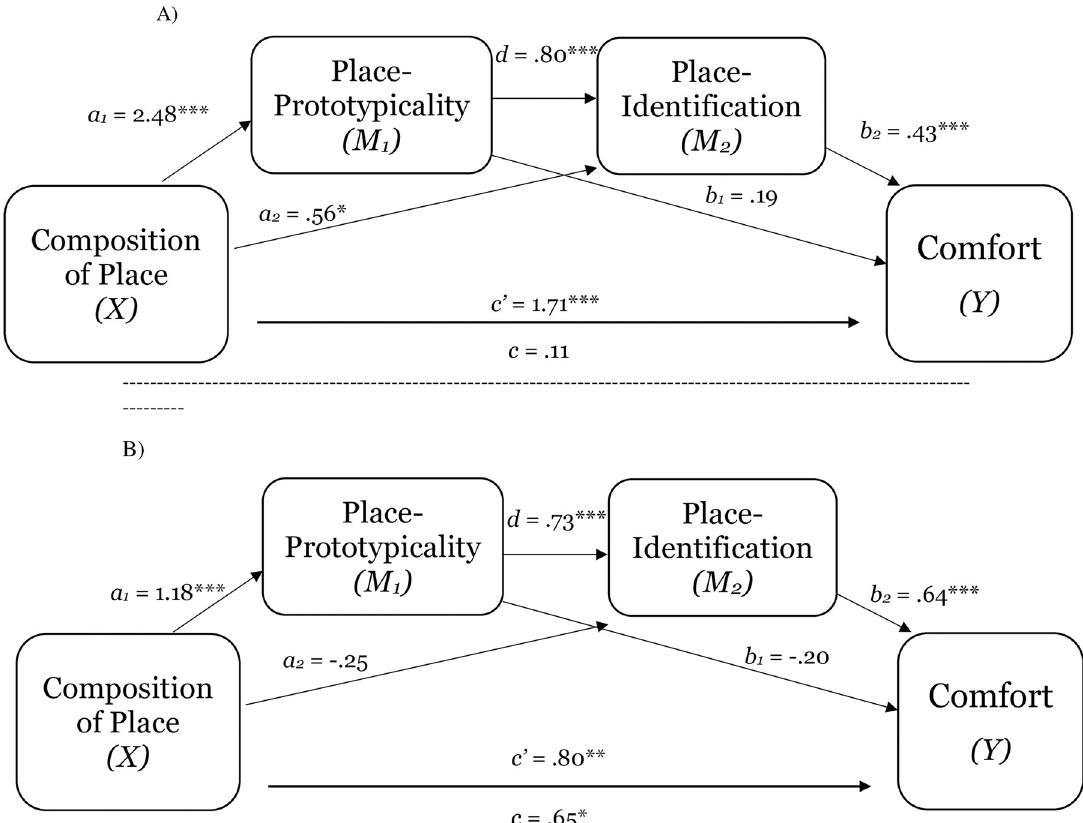
Fig 5. The serial mediating effect of place-prototypicality and place-identification in the relation between composition of place and comfort in Study 1d (Panel A) and Study 1e (Panel B). Notes: � p < .05, �� p < .01, ��� p < .001; All presented effects are unstandardized; c’ is direct effect of composition of place on comfort; c is total effect of composition of place; d is effect of place-prototypicality on place- identification (sense of belonging).